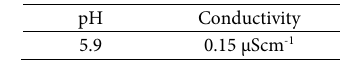
Zn O nanostructures x 1-x